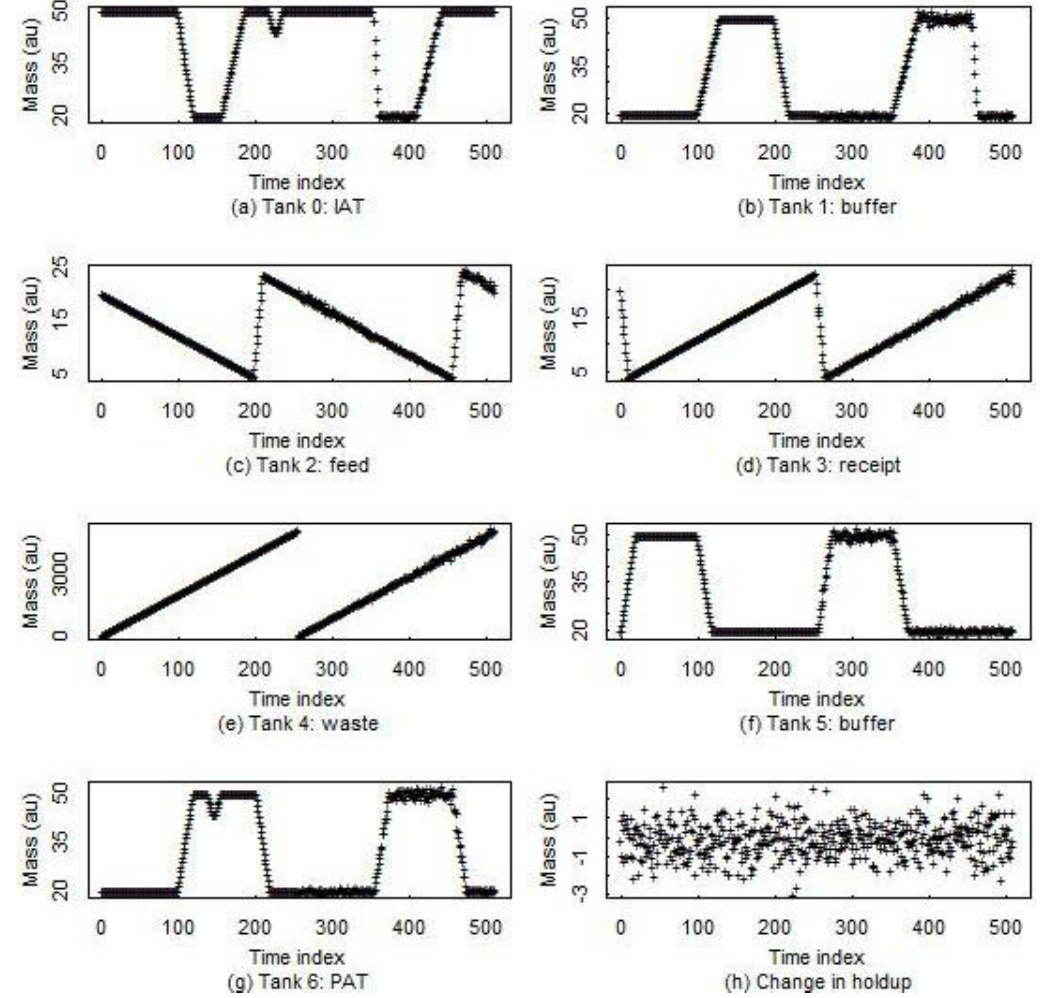
Figure 7. Example data from a 7-tank aqueous facility MBA. Some tanks are batch input, batch output (denoted B/B). Tanks that are just upstream or downstream from a separations vessel have a continous (C) mode. ( a ) Input accountability tank; ( b ) Buffer tank; ( c ) Feed tank; ( d ) Receipt tank; ( e ) Waste tank; ( f ) Buffer tank; ( g ) Output accountability tank; ( h ) Change in